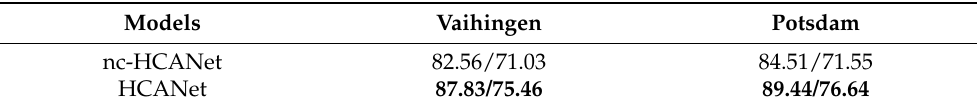
Table 5. Quantitative evaluations on two datasets. Accuracy in the OA/mIoU form, and the bold number indicates the best.